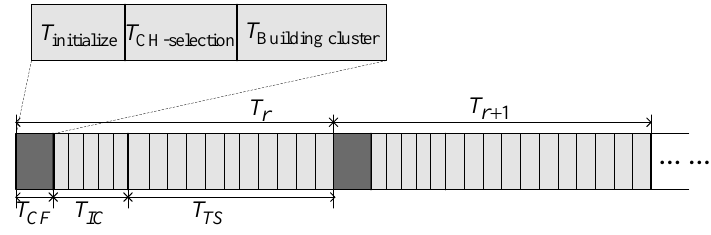
Figure 3. Time axis diagram for the three stages of the clustering protocol.